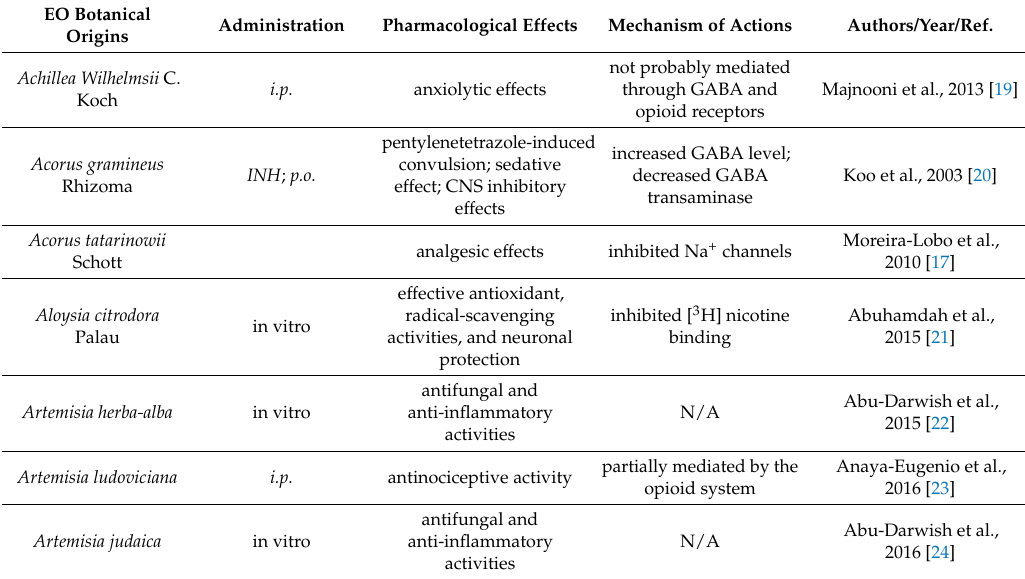
Table 1. The summary of essential oils from different plants, their pharmacological properties, and mechanism of